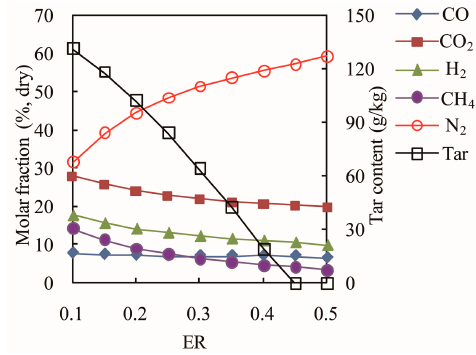
Figure 11. Effects of ER on syngas composition and tar content at T = 950 K and SBR = 0.3.